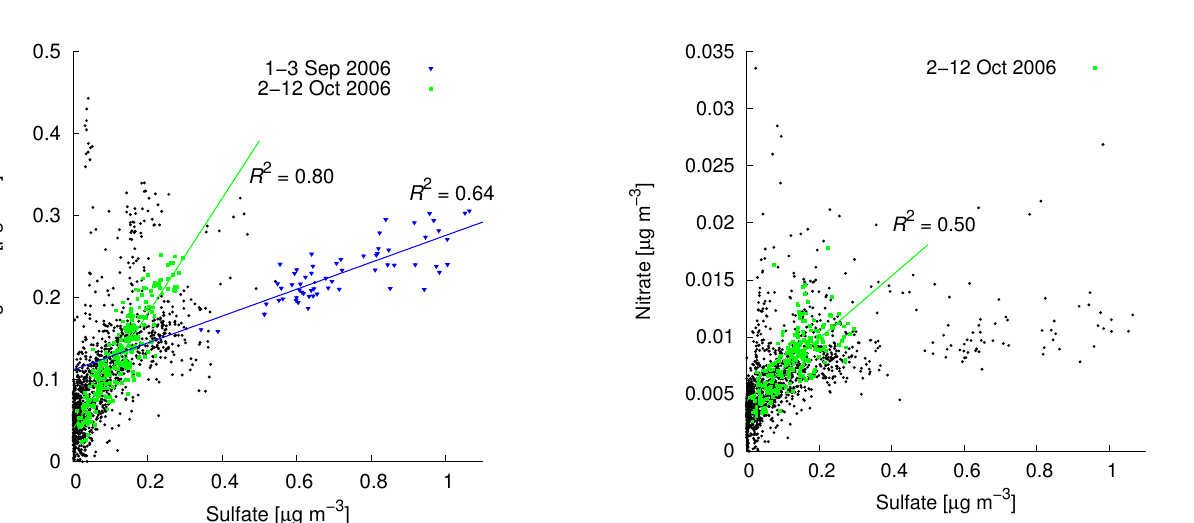
Fig. 4. Scatter plot of organics and sulfate concentrations showing data between 5 August 2006 and 12 October 2006. Two groups with exceptionally high correlations are indicated with blue and green points. The remaining data are shown as black points.